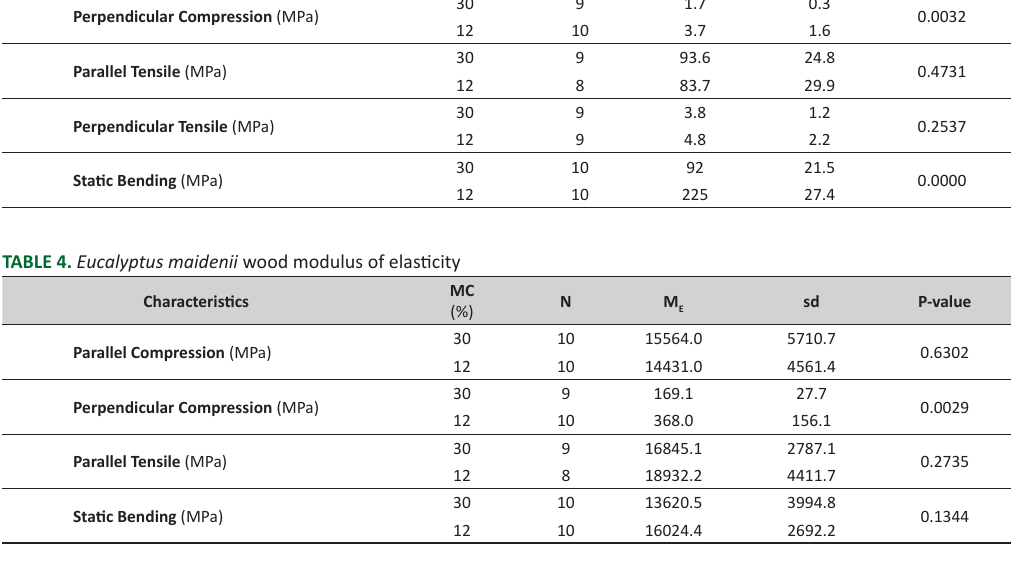
Table 4 indicated the obtained results and statistical analysis for modulus of elasticity of Eucalyptus maidenii wood. Table 5 showed the obtained results for the last five strength properties, that is, shear stress, tangential